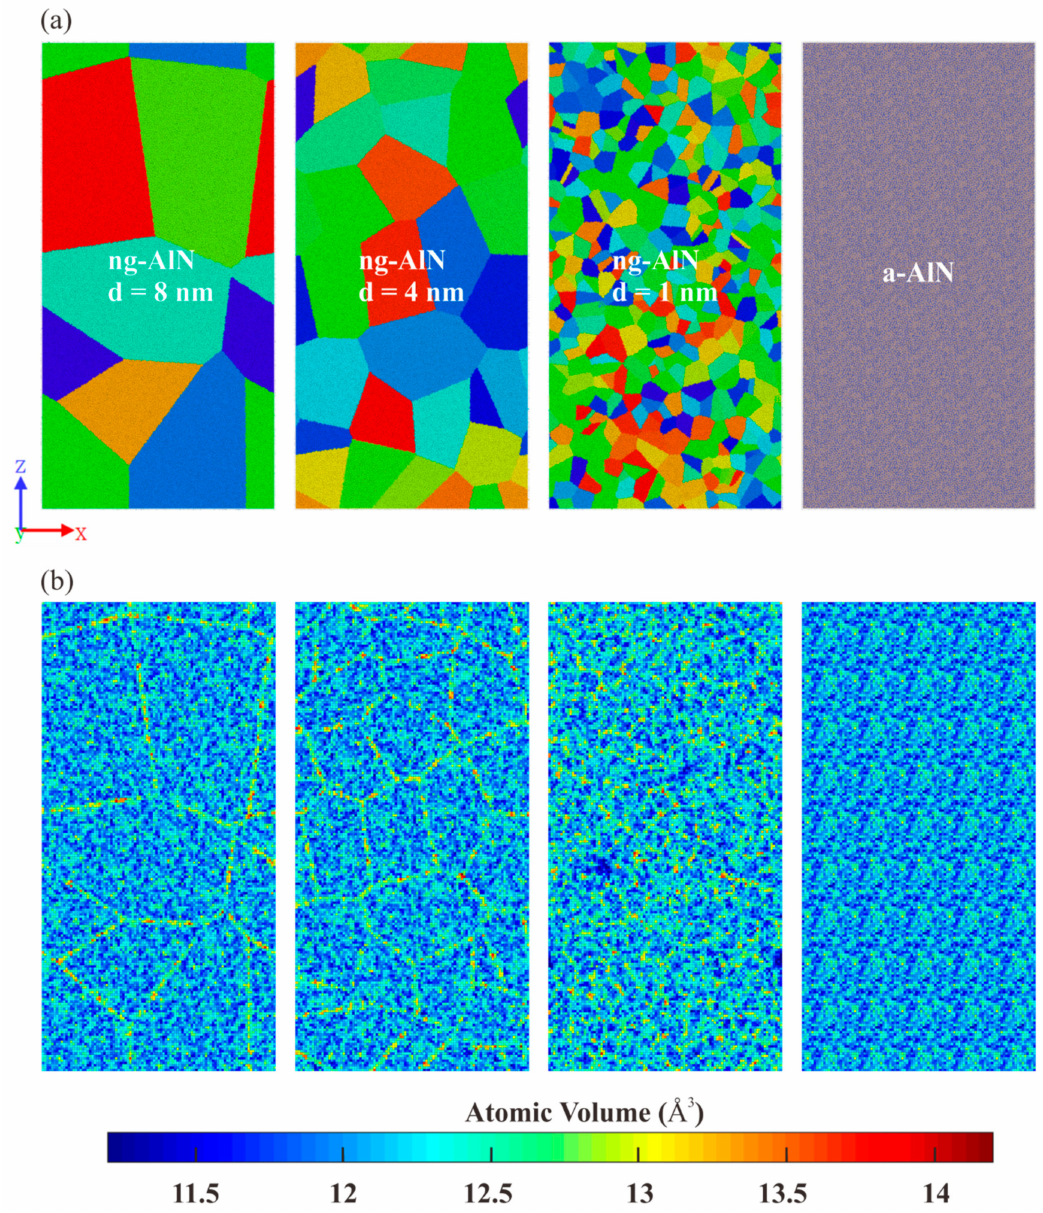
Figure 1. ( a ) Atomic configuration of ng-AlN with average grain size of 8 nm, 4 nm, and 1 nm, and a-AlN, respectively. Grains are coloured to highlight the architecture; ( b ) Distributions of atomic volume corresponding to these samples after relaxation,